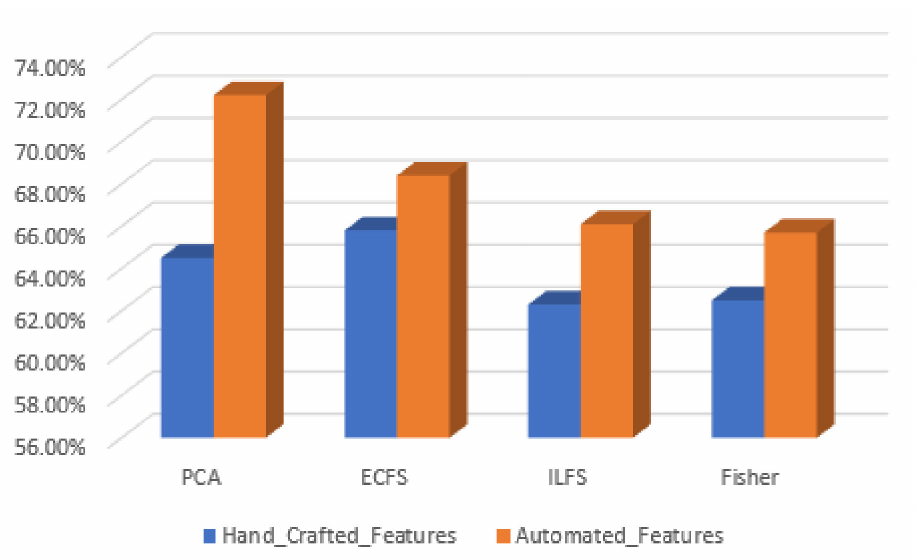
Figure 28. Accuracy for the 30 most significant features for type grading in both automated and hand-crafted features.